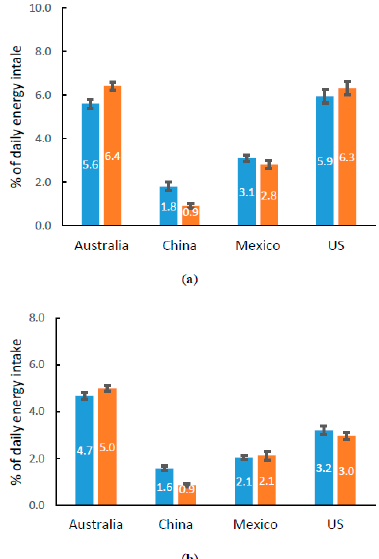
Figure 2. Energy contribution of added sugars and saturated fat during snacking occasions for children in Australia, China, Mexico, and the US (%). Data presented as Mean ± SE. Panel ( a ) and ( b ) show the percentages of energy contribution of added sugar and saturated fat, respectively. Numbers in the middle of bars are the percentages. Color of the bars represents age groups, blue for 4–8 years-old and brown for 9–13 years-old.